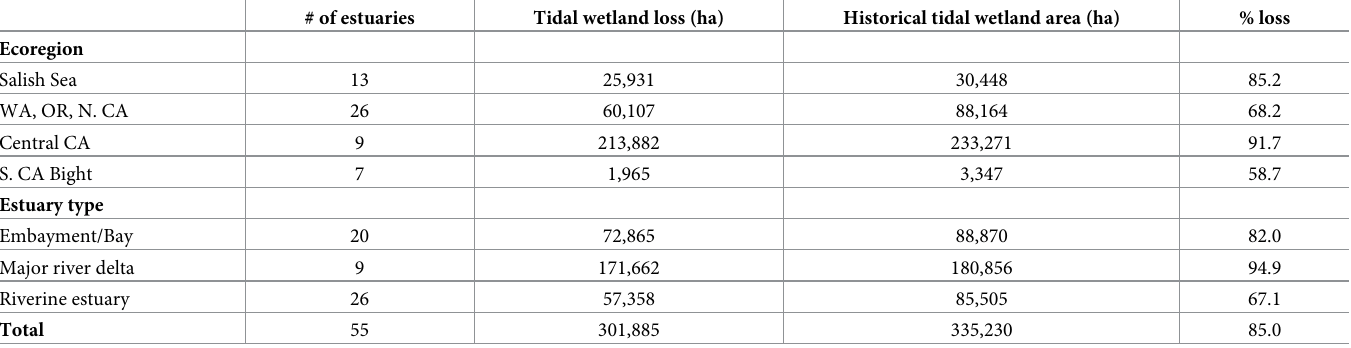
Table 5. Area and percent loss of tidal wetlands in emergent, scrub-shrub and forested classes for 55 estuaries on the Pacific Coast, by estuary type and marine ecoregion.